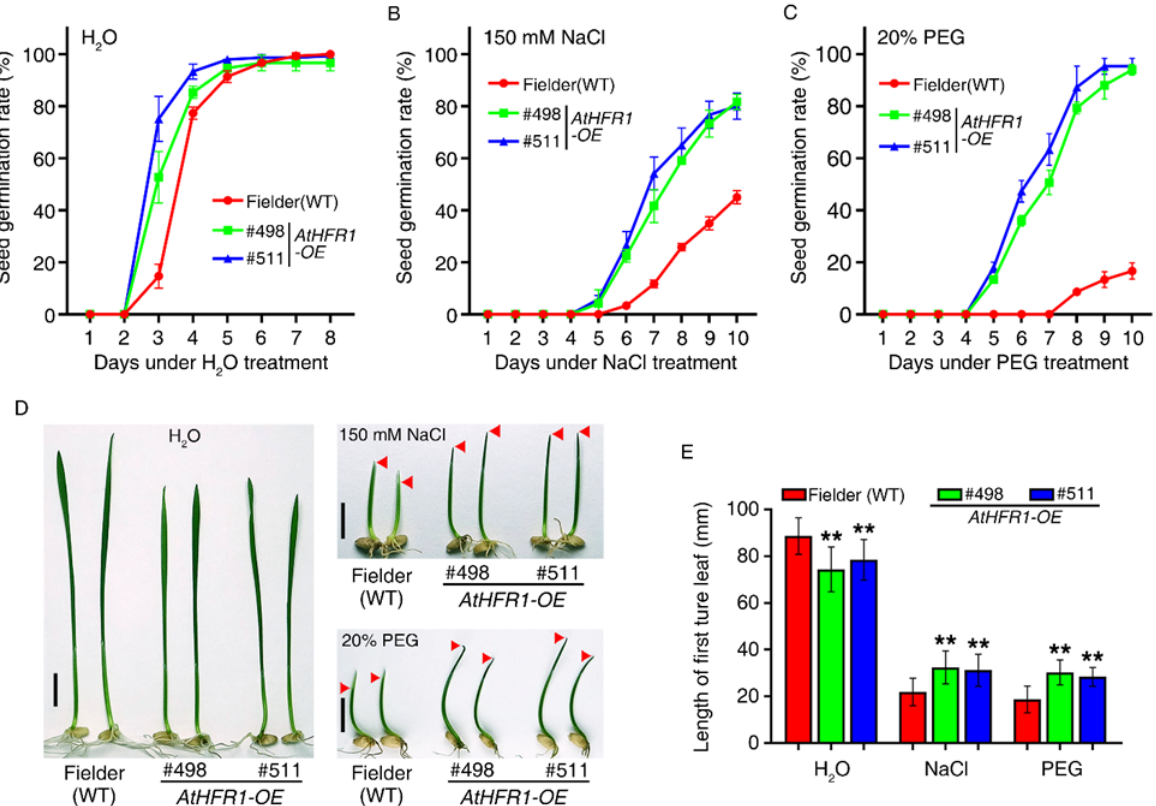
Figure 5. The AtHFR1 transgene enhances wheat tolerance to osmotic stress during seed germination: Seed germination rates of the WT (cv. Fielder) and AtHFR1 transgenic lines (#498 and #511) treated with H 2 O ( A ), 150 mM NaCl ( B ), or 20% PEG ( C ). ( D ) Seedling morphology of the WT and AtHFR1 transgenic lines (#498 and #511) treated with H 2 O, 150 mM NaCl, or 20% PEG for 8 days, showing their first true leaves. ( E ) Quantification of the first true leaf length corresponding to ( D ). Data are means ± SDs, n ≥ 40. Asterisks denote significant differences in #498 or #511 with the WT according to ANOVA (** p < 0.01).